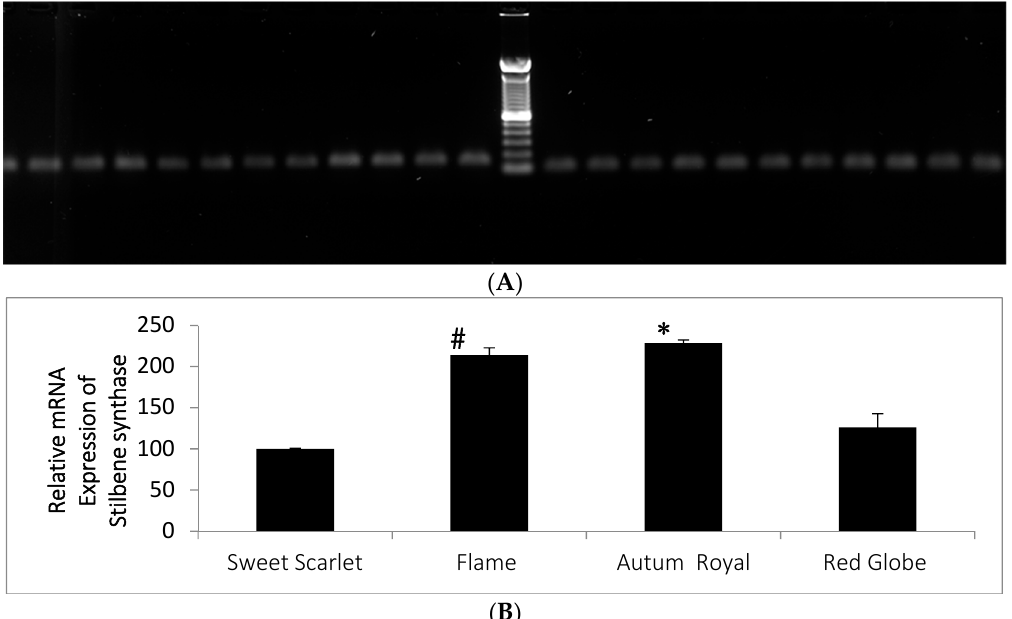
Figure 4. Stilbene synthase ( STS ) gene expression analysis in tested four varieties of table grapes. A. Amplified products of STS (137 bp) and beta-tubulin (86 bp) by PCR analysis. B. Relative expression of STS gene in different varieties of table grapes found in Winnipeg market. (The results are ex- pressed as SE ± (n = 3). When compared to Sweet Scarlet significant interactions are shown with # p < 0.005, * p < 0.0005).